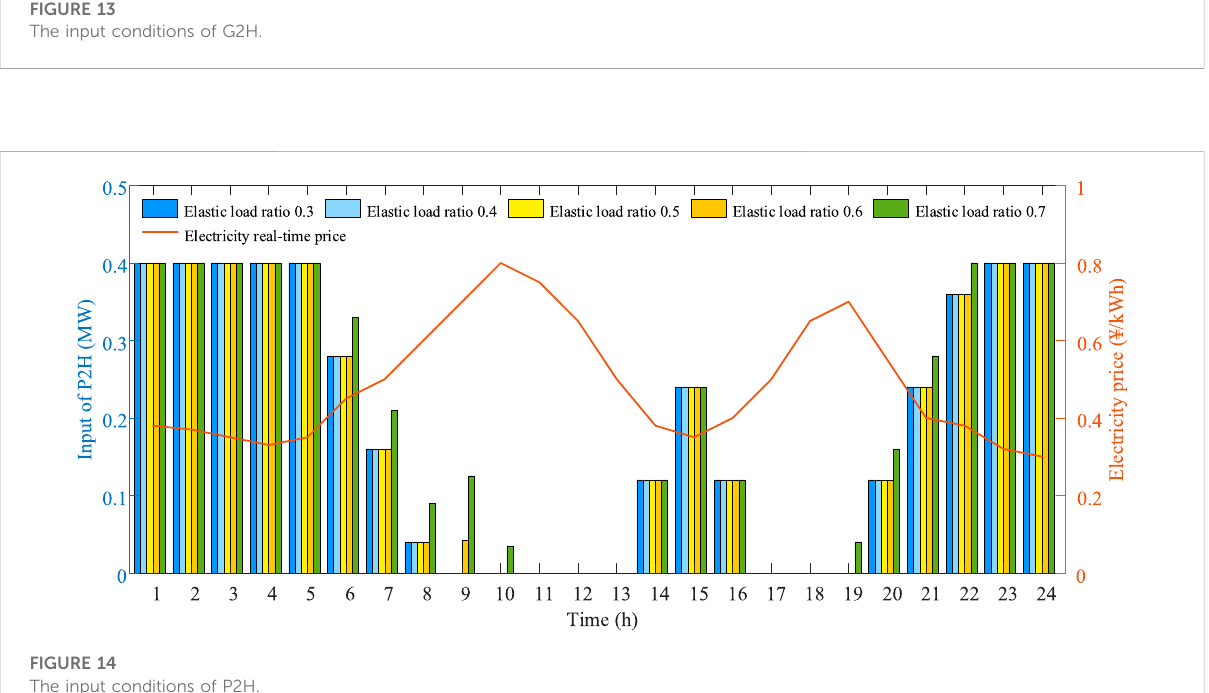
FIGURE 14 The input conditions of